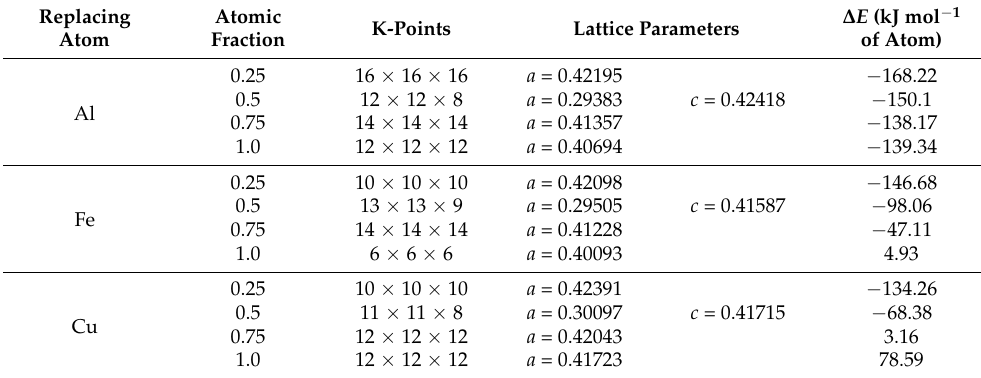
Table 13. The calculated elastic constants for Ti (1 − x) M x N intermetallics. Replacing Atom